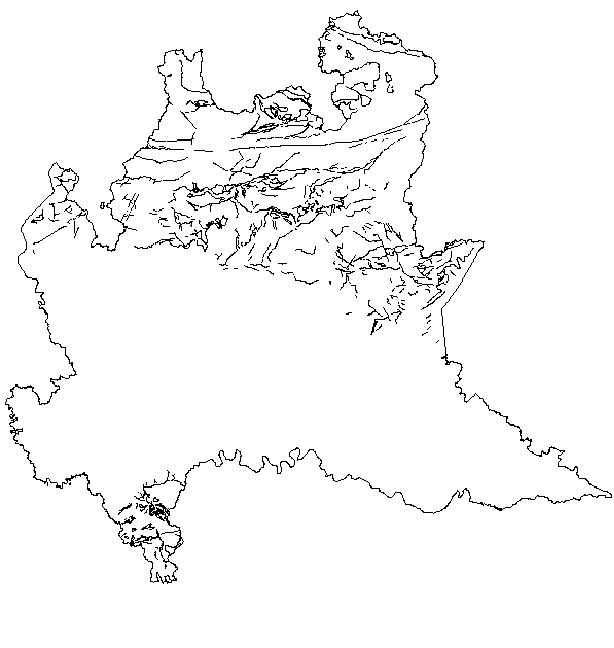
Figure 5. Tectonic framework in